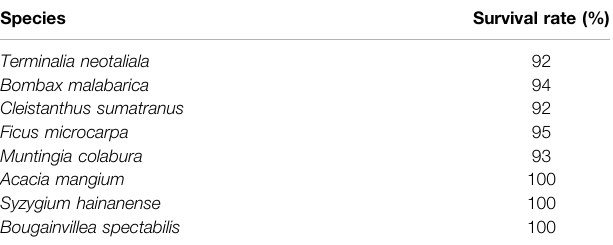
TABLE 1 | Survival rates for the eight fast-growing tree species ( Terminalia neotaliala (Combretaceae), Bombaxmalabarica (Bombacaceae), Cleistanthus sumatranus (Euphorbiaceae), Ficus microcarpa (Moraceae), Muntingia colabura (Elaeocarpaceae), Acacia mangium (Leguminosae), Syzygium hainanense (Myrtaceae) and Bougainvillea spectabilis (Nyctaginaceae)) after 3 ° years of reforestation.